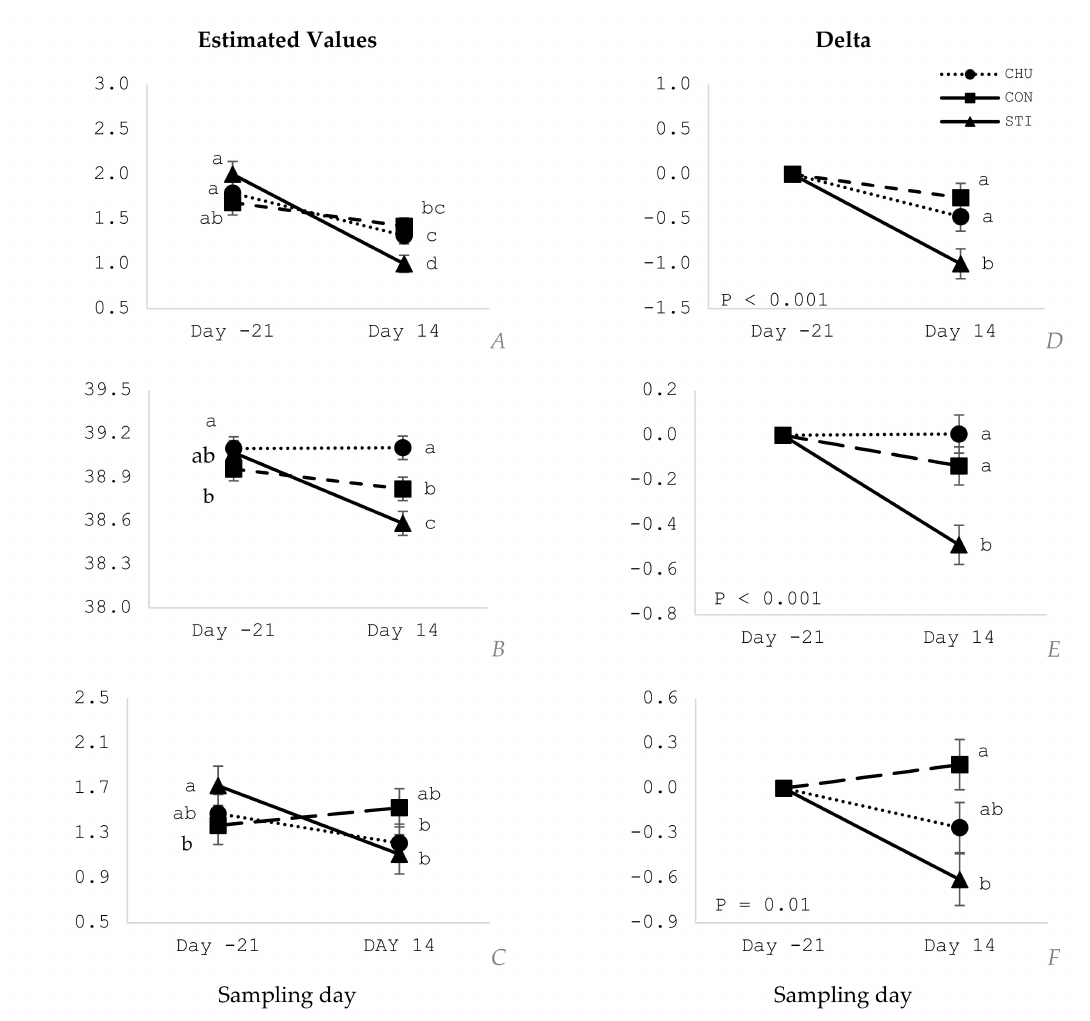
Figure 4. Estimated values (left column; A – C ) with interaction effect of treatment and sampling day and, delta values (right column; D – F ) with treatment effect of Stimulated (STI), Chute (CHU) and Control (CON) groups on sampling days − 21 and 14. a, b: different lowercase letters indicate statistical difference ( p ≤ 0.05) and equal letters do not differ significantly ( p >